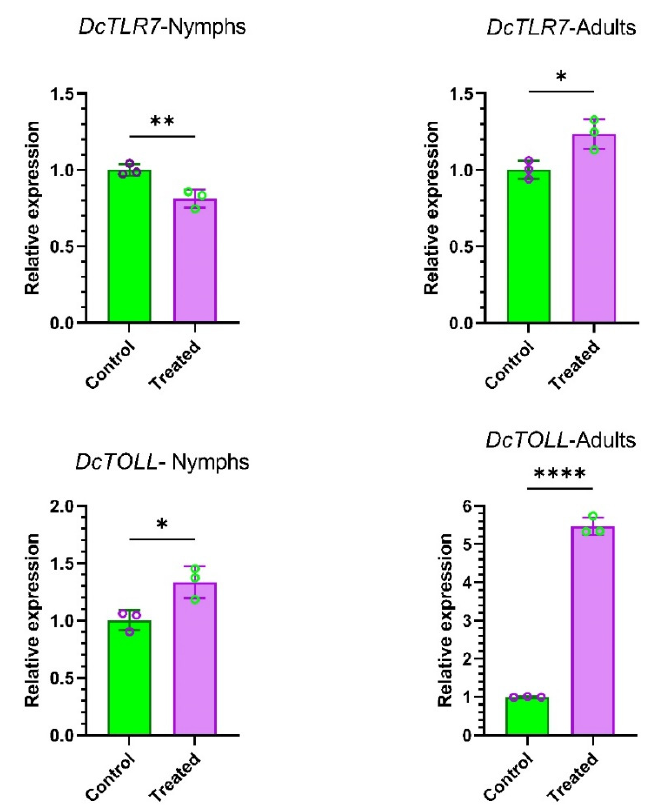
Figure 7. Expression profiles of DcTLR genes in nymphs and adults of Diaphorina citri . Mean ± SEM values were obtained from three biological replicates and three technical replicates. * p < 0.0332, ** p < 0.0021, **** p < 0.0001, Student’s t -test.